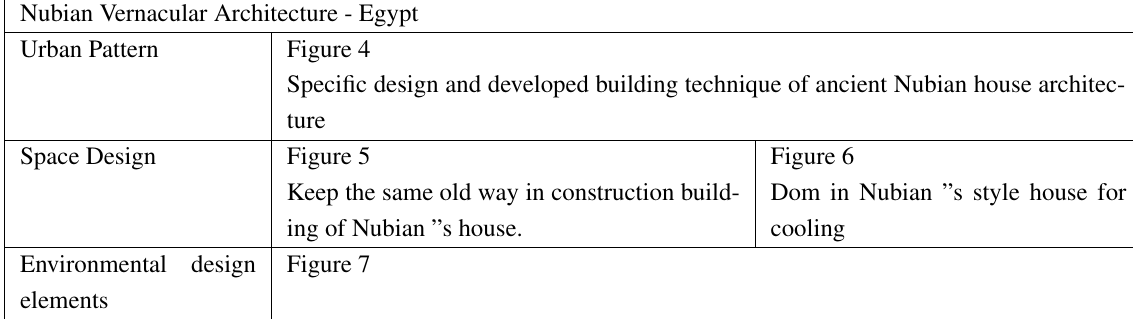
Continued on next page